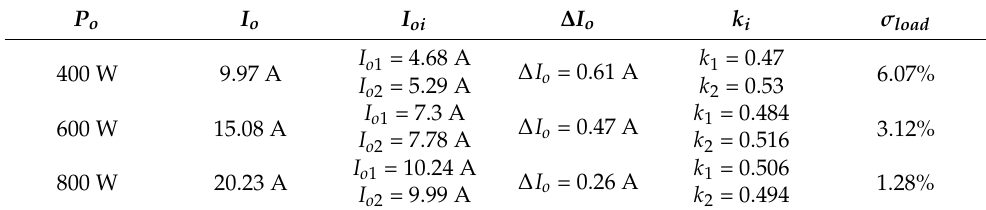
Table 4. Data comparison of different output power after only using calculation result when a = 1.2.